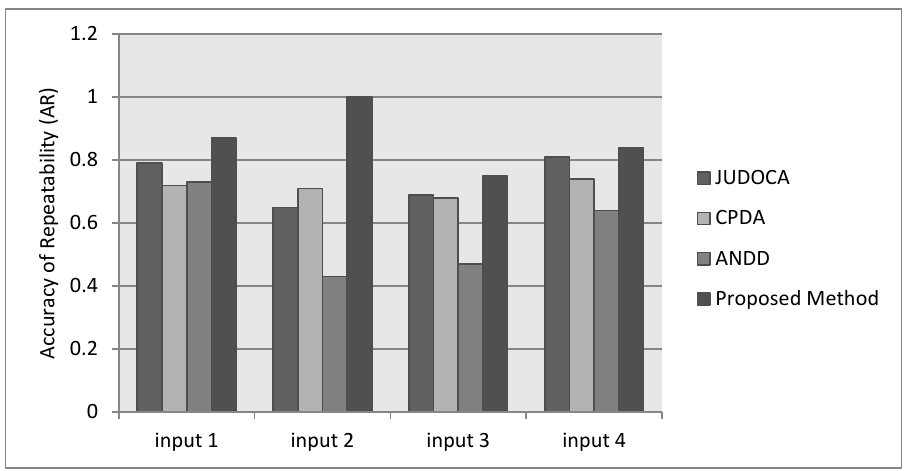
Figure 11. Comparative results of the different methods under the